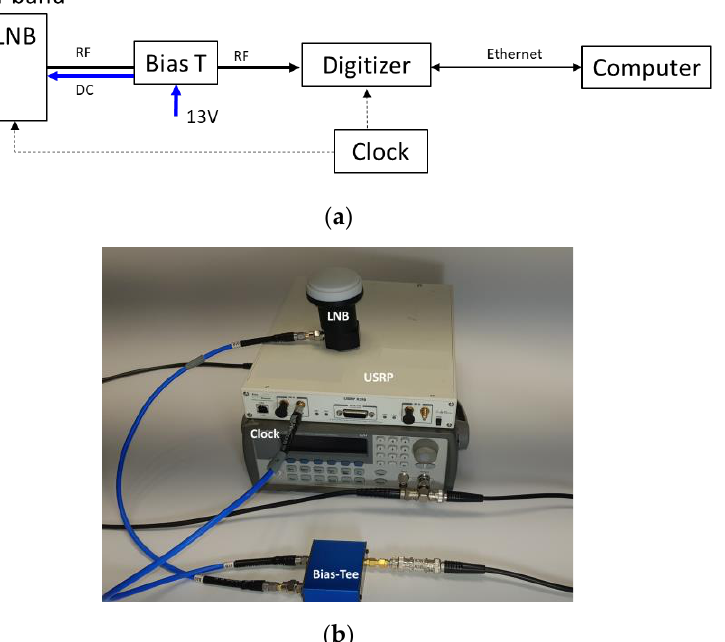
Figure 1. ( a ) Sketch of the recording chain, LNB down-convertor used without a parabolic reflector. ( b ) Photo of the experimental